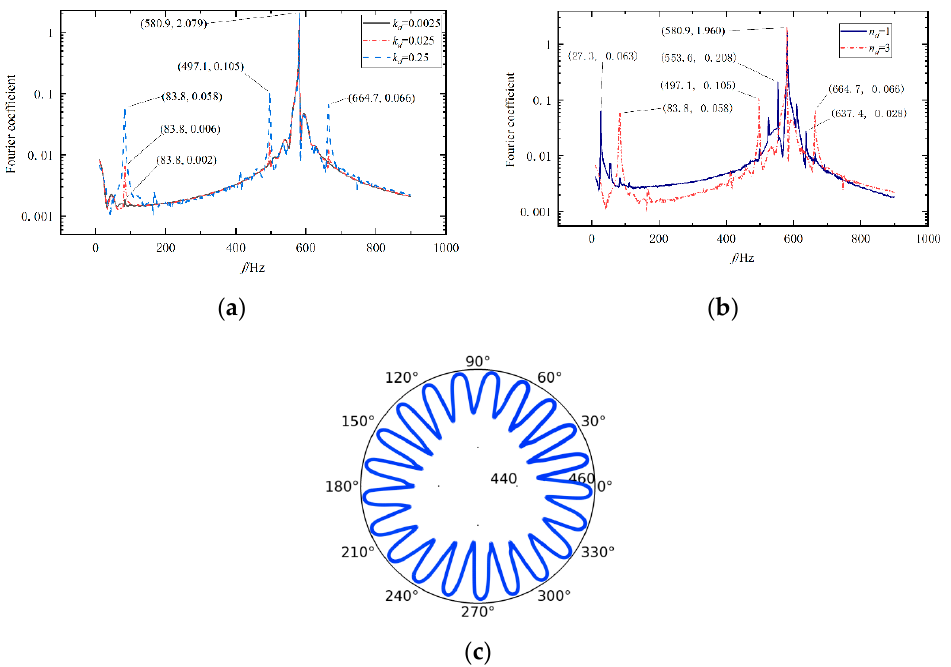
Figure 8. Effect of wheel rail vertical dynamic force: spectrum diagram under ( a ) n d = 3 and ( b ) k d = 0.25; wear characteristic under ( c ) n d = 3 and k d = 0.25.